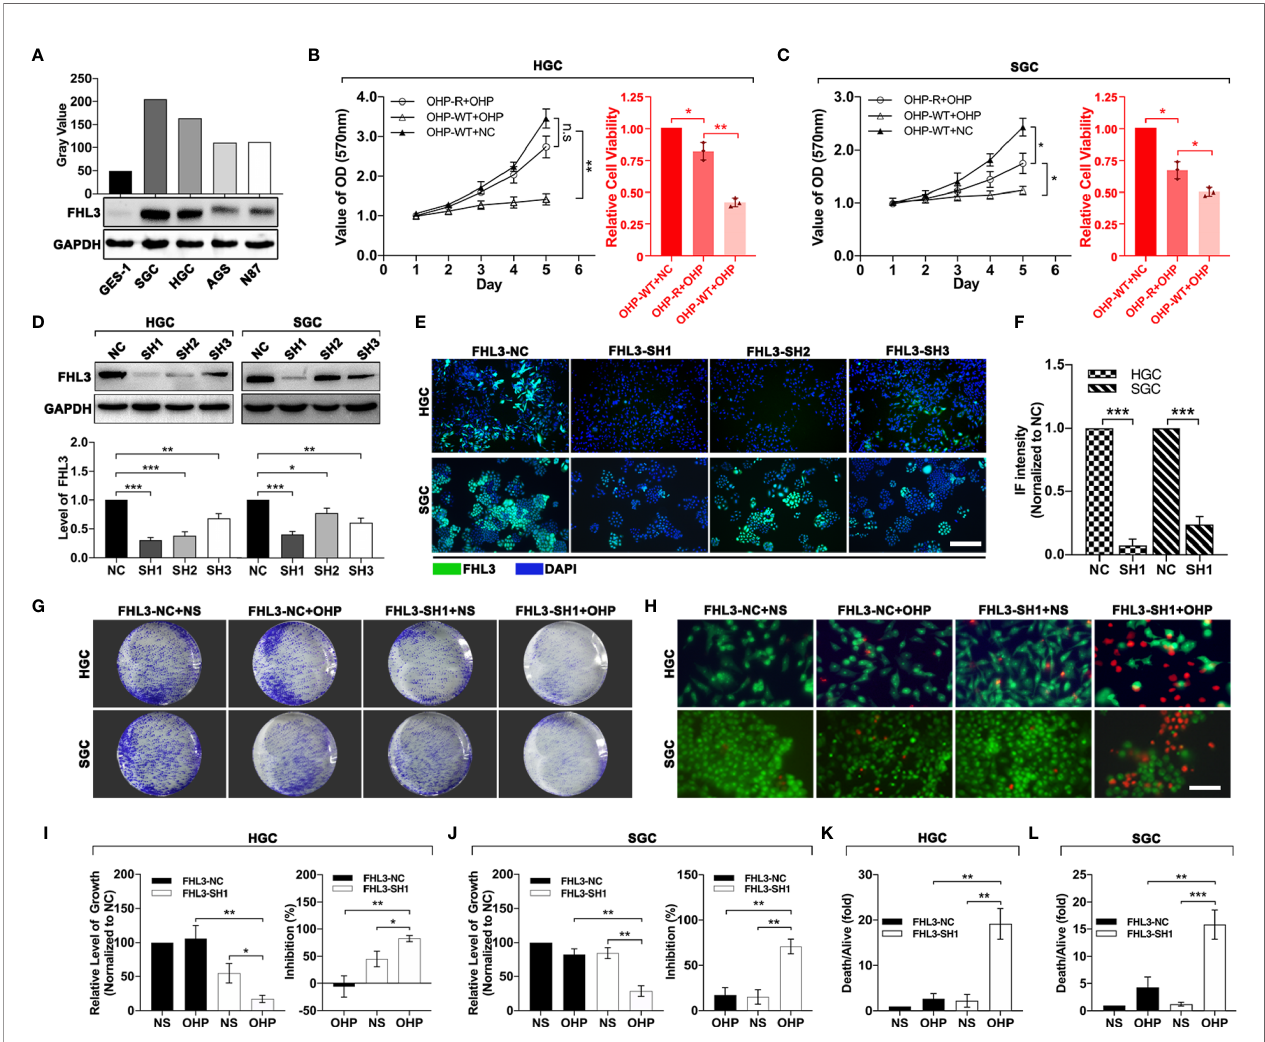
FIGURE 3 | FHL3 knockdown signi fi cantly sensitized the ef fi cacy of OHP treatment in gastric cancer. (1) The gastric cancer cells were screened for FHL3-high- expression cell lines by western blot (A) ; (2) MMT was performed to detect the growth of OHP-resistance cell lines when treated with NS or OHP for 5 days in HGC and SGC cell lines (B, C) ; (3) The knockdown ef fi ciency of the four FHL3 knockdown sequences in OHP-resistance cell lines, through western blot and immuno fl uorescence analysis (100× magni fi cation); we found that FHL3-SH1 was the most ef fi cient sequence for down-regulation of FHL3 (D – F) ; (4) OHP- resistance FHL3-NC and SH1 cell lines were treated with OHP to detect the proliferation via colony formation (G, I , J) ; (5) OHP-resistance FHL3-NC and SH1 cell lines were treated with OHP to detect the ef fi cacy of OHP via colony formation and live and death staining assay (200× magni fi cation, H, K and L